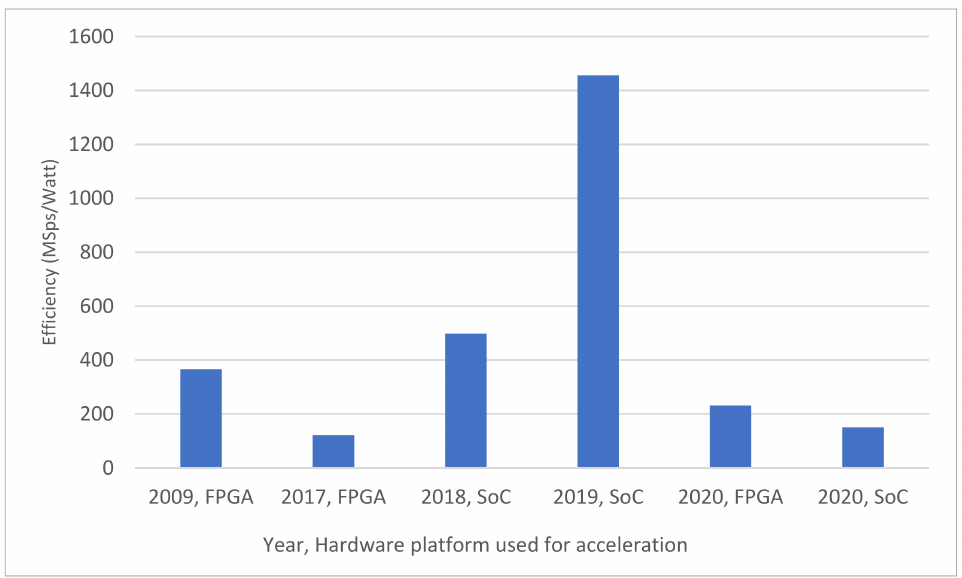
Figure 17. The best efficiency, in MSps/Watt, obtained by six hardware-accelerated imple- mentations of hyperspectral image compression algorithms (the displayed results refer to the works in [49,64,76,115,116,139],